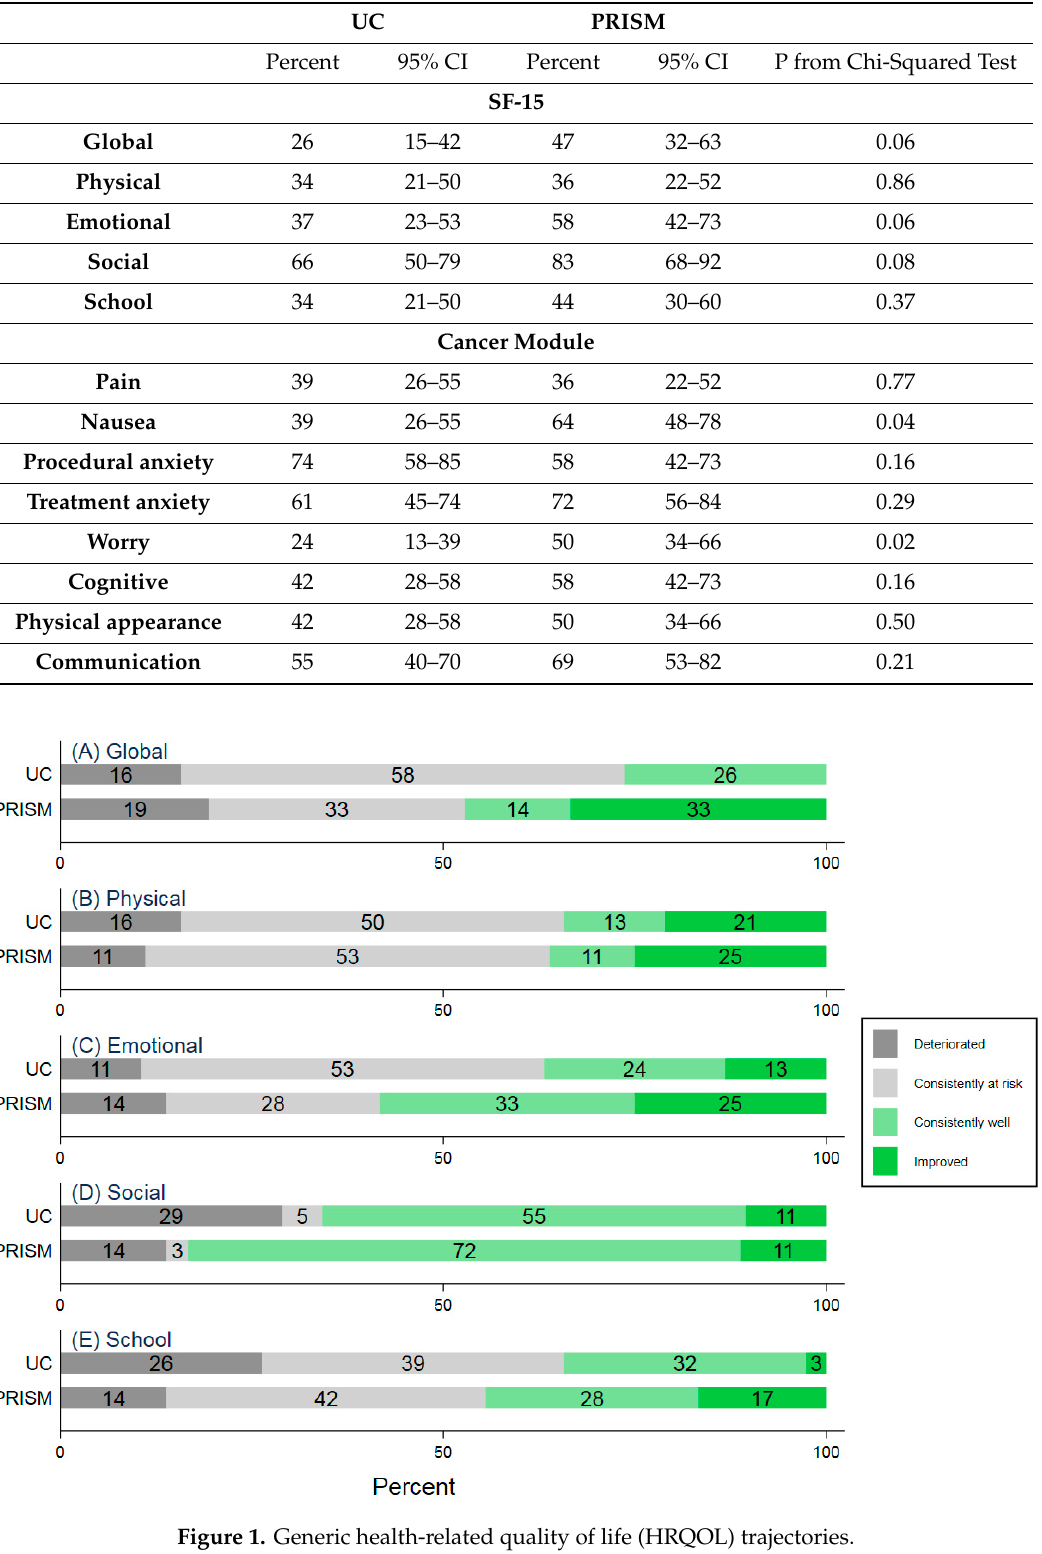
Table 2. Percent positive trajectories (95% CI) for PedsQL SF-15 and Cancer Module subdomains, by study arm.